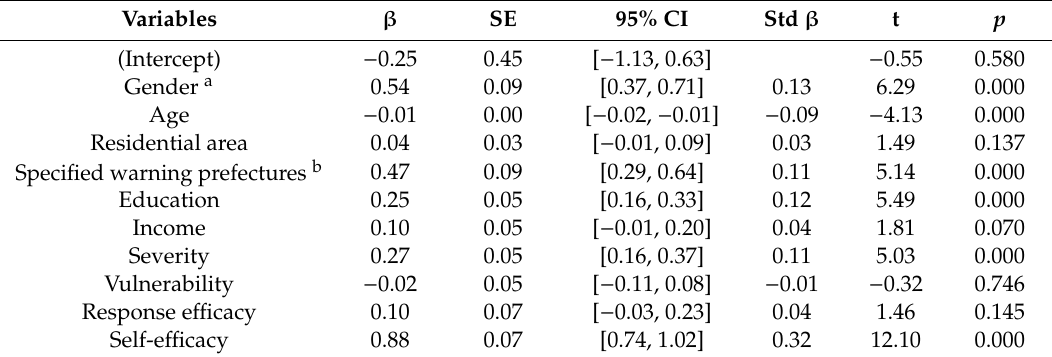
Table 3. Regression analysis to predict staying at home ( n = 1980) (Adjusted R 2 = 0.21).